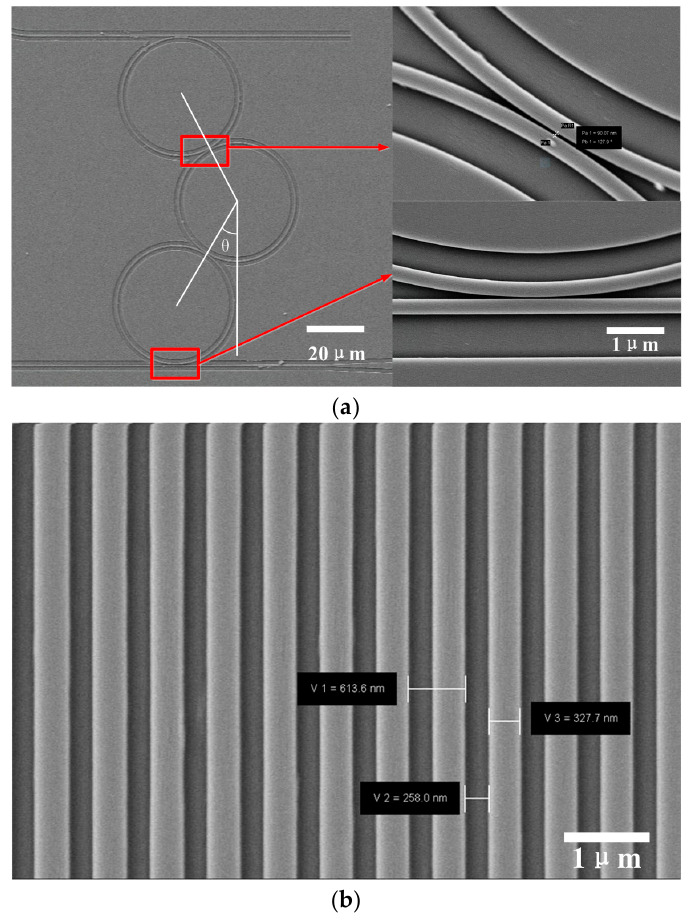
Figure 5. SEM of the cascaded rings and the gratings: ( a ) rings and straight waveguide ( b ) the grating couplers.